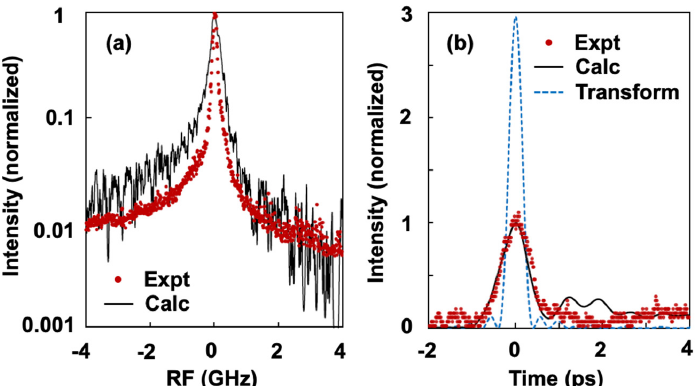
Figure 6. ( a ) RF spectrum and ( b ) mode-locked pulse from theory (solid black curves) and experi- ment (solid red curves). The frequency and time are referenced to the peak values. The dashed blue curve in ( b ) shows the transform-limited pulse based on the lasing bandwidth.